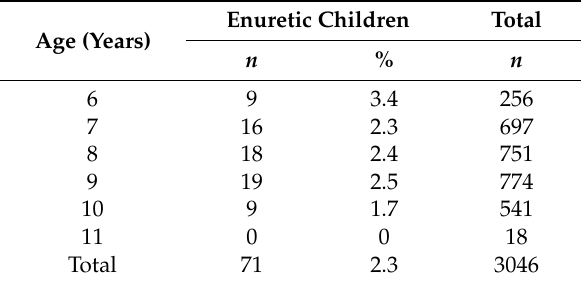
Table 1. Distribution of enuretic children according to age.